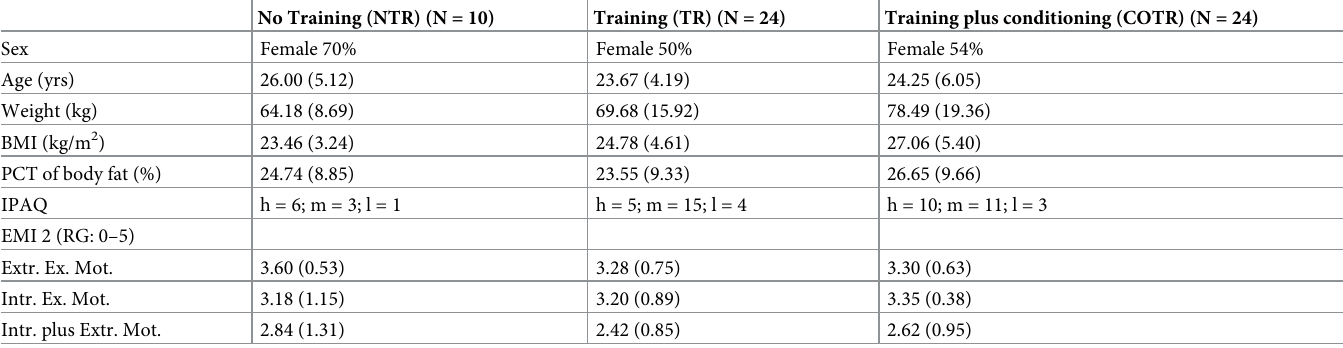
Table 1. Mean and standard deviations of body characteristics and psychometric